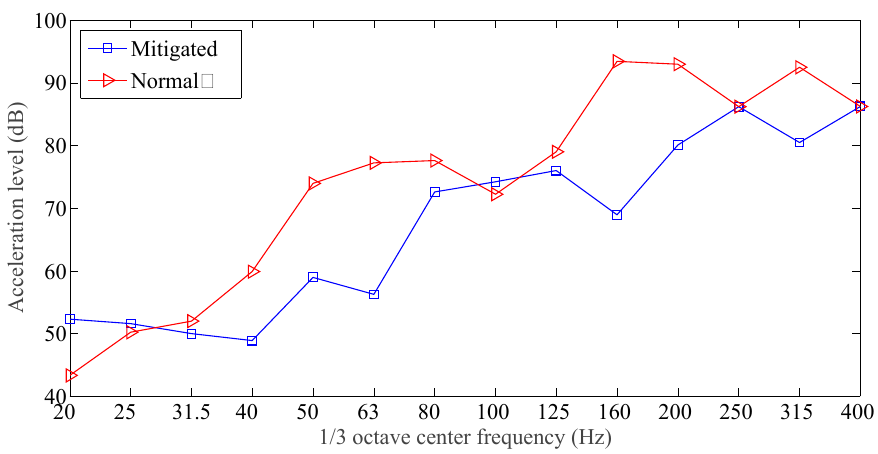
Figure 12. Acceleration spectrum for testing point 2.